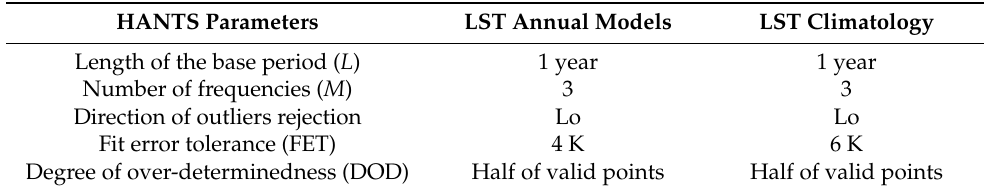
Table 2. Parameters used in HANTS algorithm to pre-process LST data.